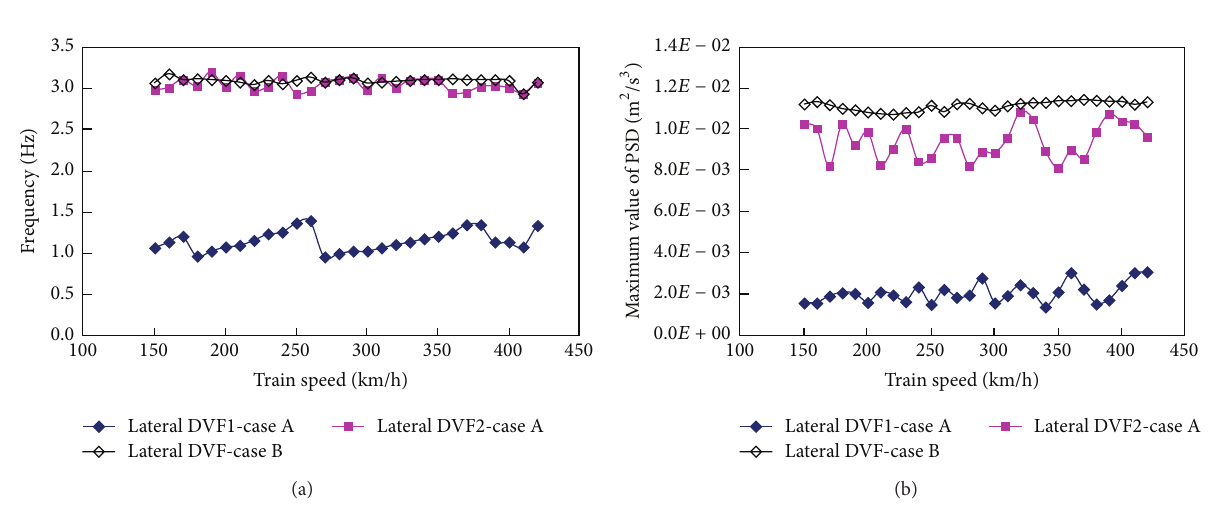
Figure 8: Motor carbody lateral acceleration with respect to train speed. (a) DVF. (b) Maximum value of